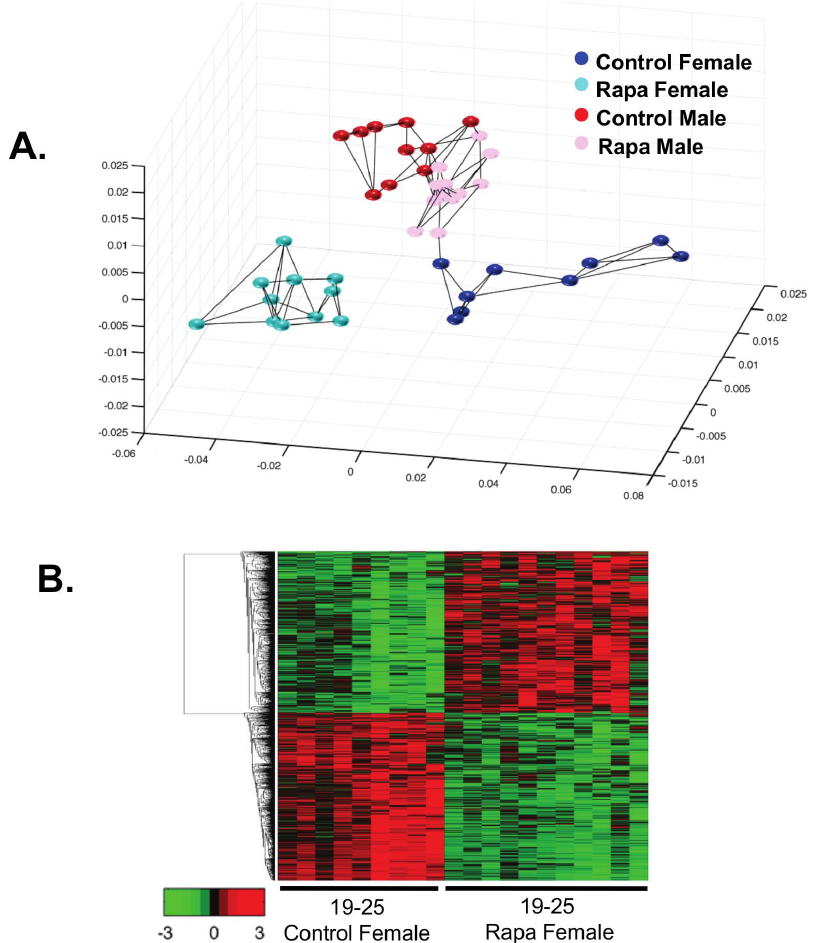
Figure 6. Multidimensional scaling and heatmap analysis show that 6-months Rapa females are separate and different from control females. Multidimensional scaling analysis of the transcriptome data from the 42 mice fed Rapa 6-months from 19 to 25 months of age was conducted using all the probes detected (17,082 probes) on the microarrays ( A ). Control males are shown in red, Rapa males in pink, control females in blue, and Rapa females in cyan. Each dot represents one sample and the lines indicate the three nearest neighbors. Heatmap analysis of all the transcripts that are significantly altered by 6-months Rapa female compared to control females are shown ( B ). The genes were clustered using linkage hierarchical cluster with Euclidean distance and the expression of transcripts are shown with red for high, black for middle, and green for low expression. A list of the transcripts that significantly changed with 6-months Rapa feeding is shown in the same top to bottom clustering order as the heatmap in File S2,